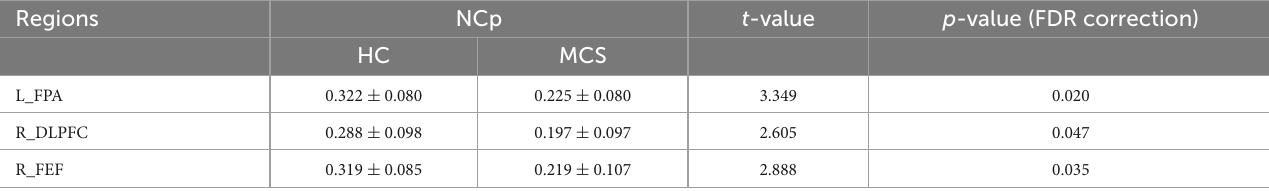
TABLE 3 Comparison of NCp between HC and MCS groups. Regions NCp